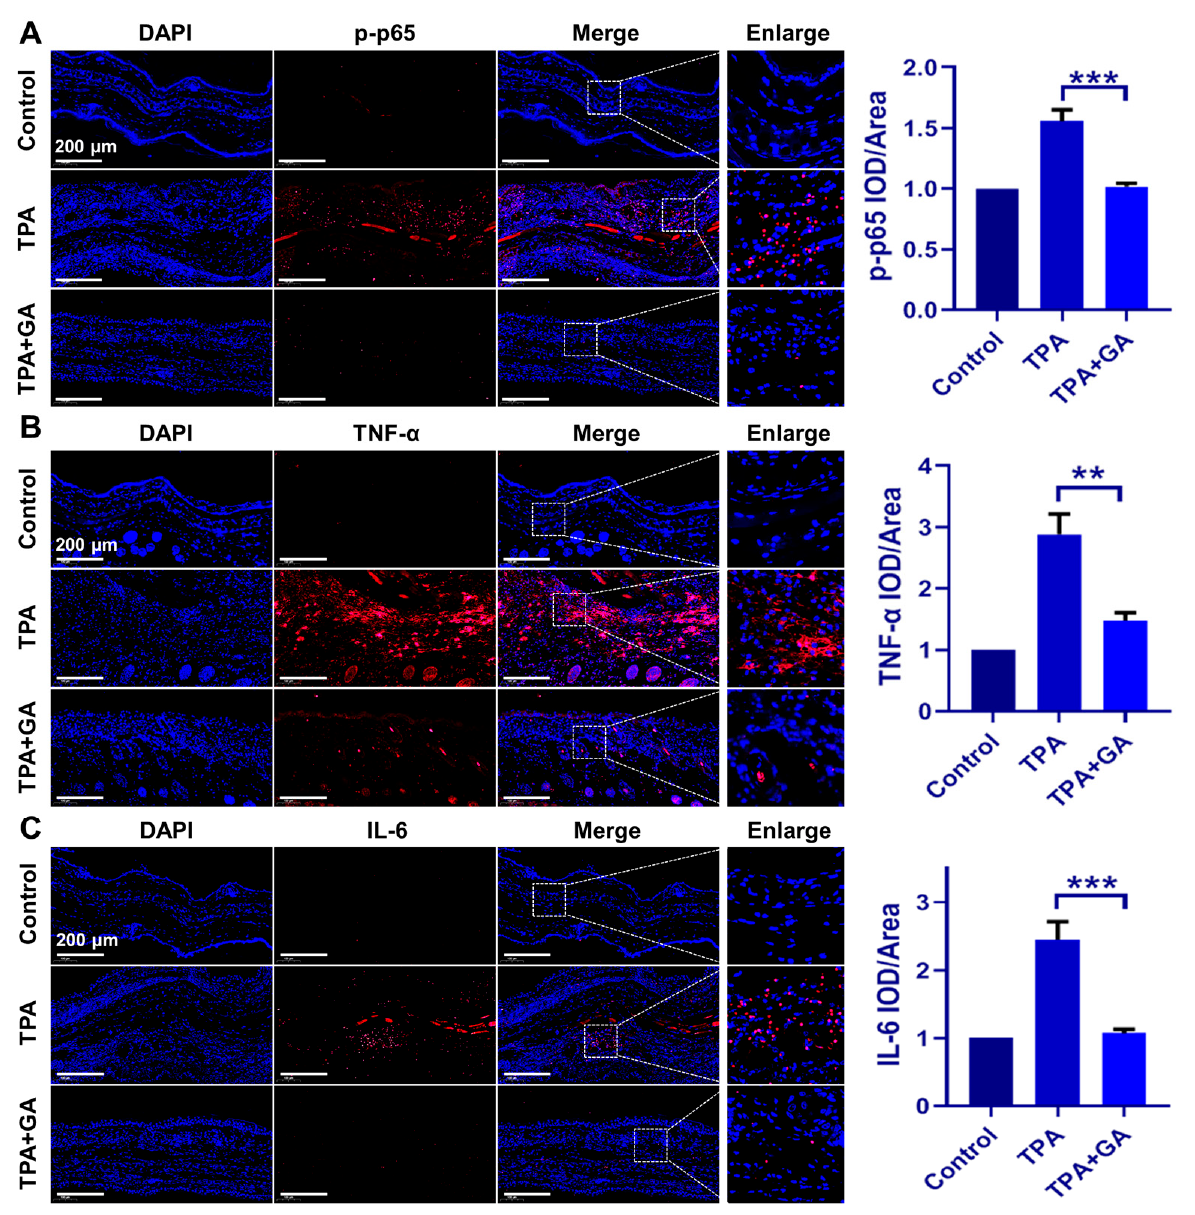
Figure 5. Immunofluorescence staining of mice ear samples following GA administration in the ICD model. Expression of p-p65, TNF- α and IL-6 is shown in red fluorescence, while the nucleus was stained in blue by DAPI. Experiments were undertaken to confirm the suppression of ( A ) p-p65, ( B ) TNF- α and ( C ) IL-6 expression by GA (50 µM), relative to the TPA-only group. The magnification for all images is the same. Magnification = 20 × , Scale bar = 200 µ m. The positive area in each group was qualitatively analyzed. The data are shown as mean ± SD of triple tests, ** p < 0.01, *** p < 0.001.